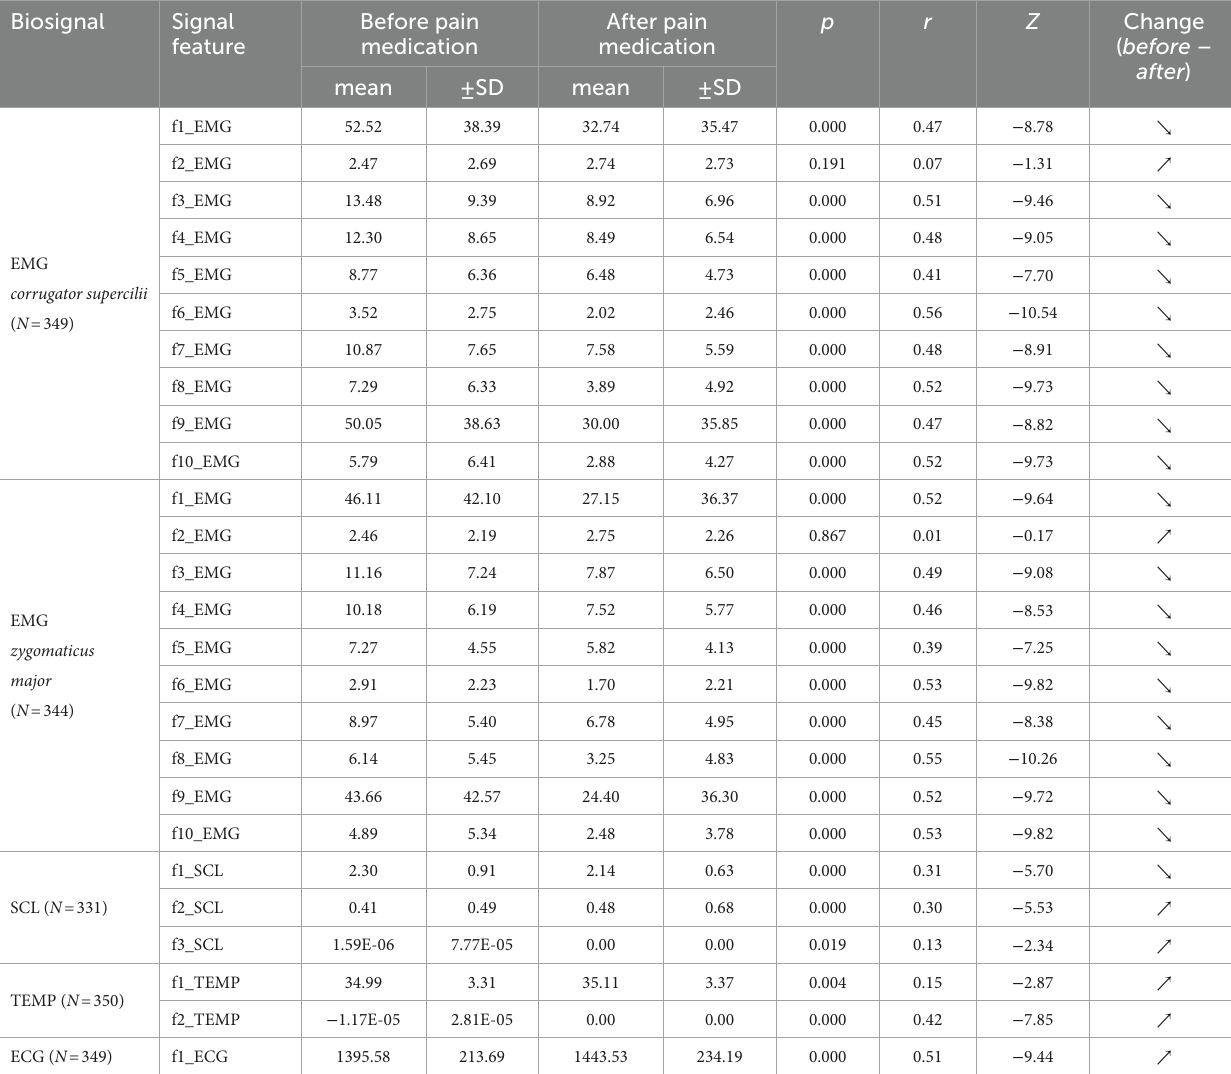
TABLE 2 Biosignal activity represented through features directly ‘ before ’ and 5 min ‘ after ’ pain medication: results of Wilcoxon signed-rank tests and associated effect sizes.